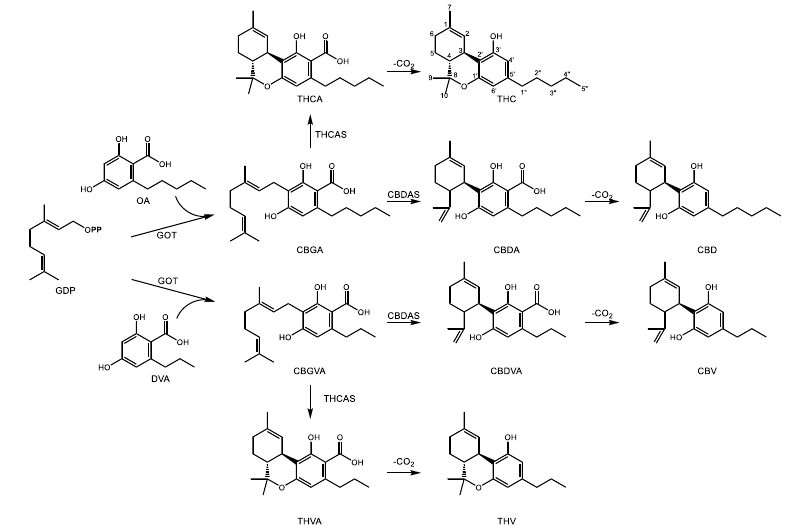
Figure 4. Steps in the biosynthesis of major cannabinoids in C. sativa and C. indica . Metabolites are as